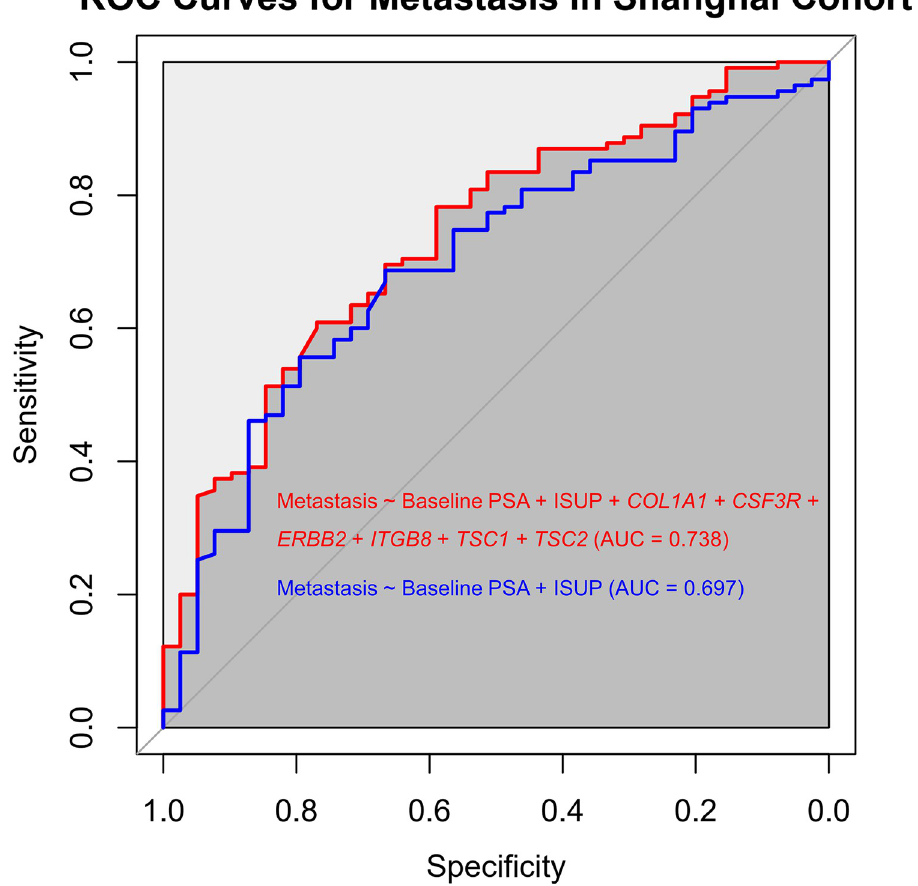
Fig 7. Receiver operating characteristic (ROC) curves for the prediction of metastasis in the Shanghai cohort. The model included baseline Prostate-Specific Antigen (PSA), International Society of Urological Pathology (ISUP) grade, and COL1A1 , CSF3R , ERBB2 , ITGB8 , TSC1 and TSC2 expression level. The model was built using the Hong Kong cohort by logistic regression, and then validated in the Shanghai cohort. According to the area under the curve